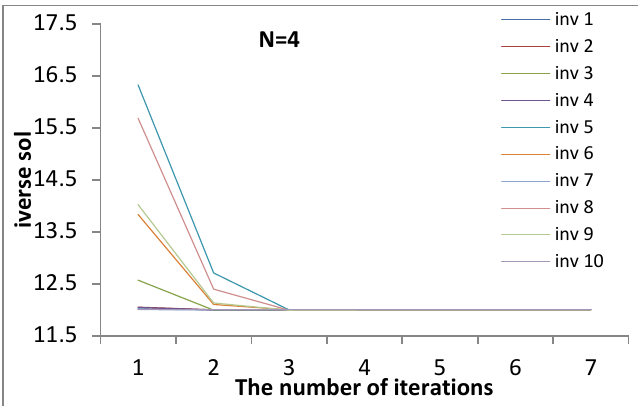
Figure 5. The inverse convergence curve of IABC colony, N = 4.